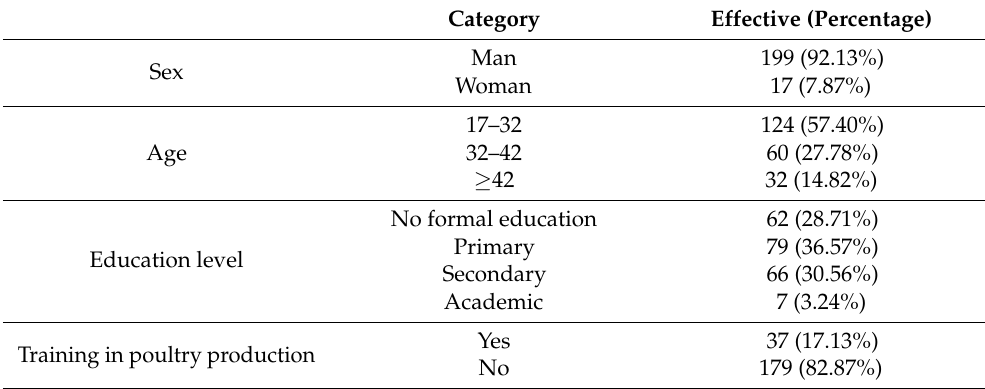
Table 1. Sociodemographic characteristics.